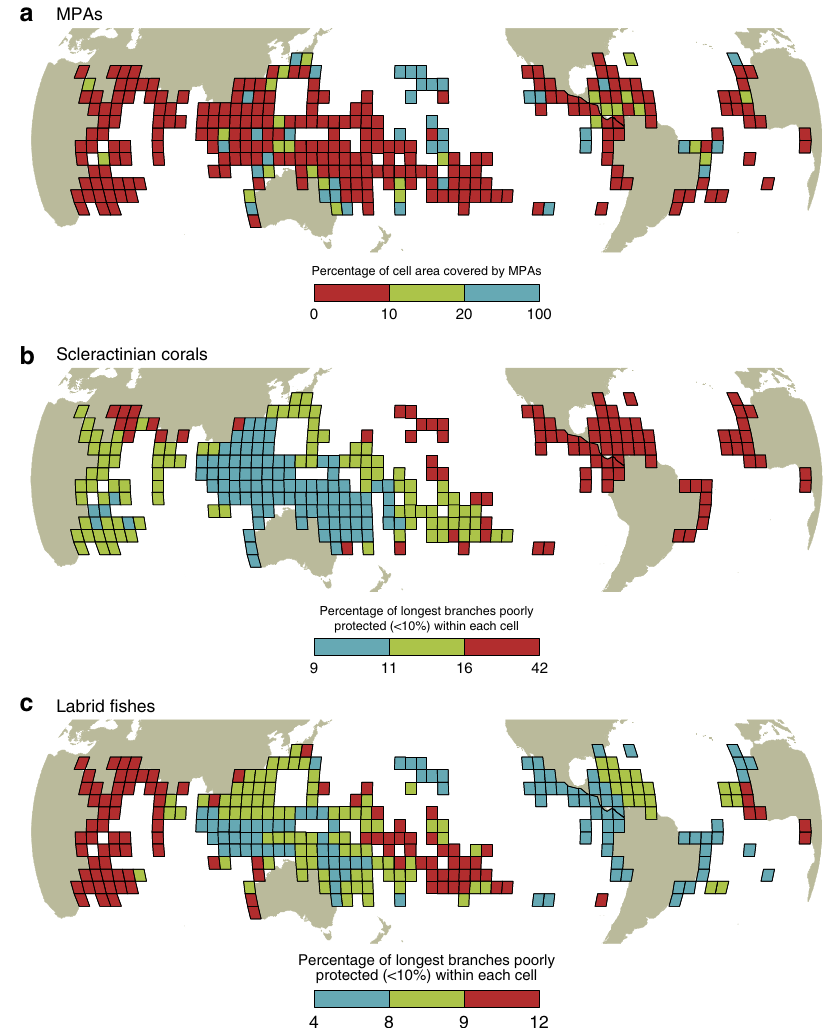
Figure 3 | Global distribution of protection deficits to secure the Tree of Life on coral reefs. Global maps representing, for each cell (5 (cid:2) (cid:2) 5 (cid:2) ), the percentage of coral reef habitat covered by MPAs ( a ), and the proportion of the longest evolutionary branches (top 10%) that receive less than the critical 10% coverage by the MPA system within coral ( b ) and fish ( c ) local assemblages. Colours correspond to three categories of values based on percentage of coverage for MPAs and on tertiles for corals and